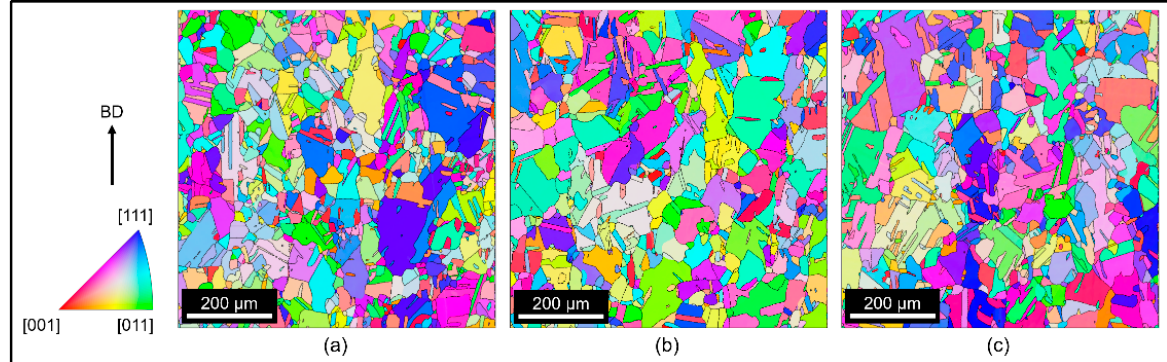
Figure 13. EBSD maps of L-PBF samples after 1100 °C, 3 h solid solution heat treatment. Recrystallization occurred for each L-PBF condition: ( a ) L-PBF-1; ( b ) L-PBF-2; ( c ) L-PBF-3.